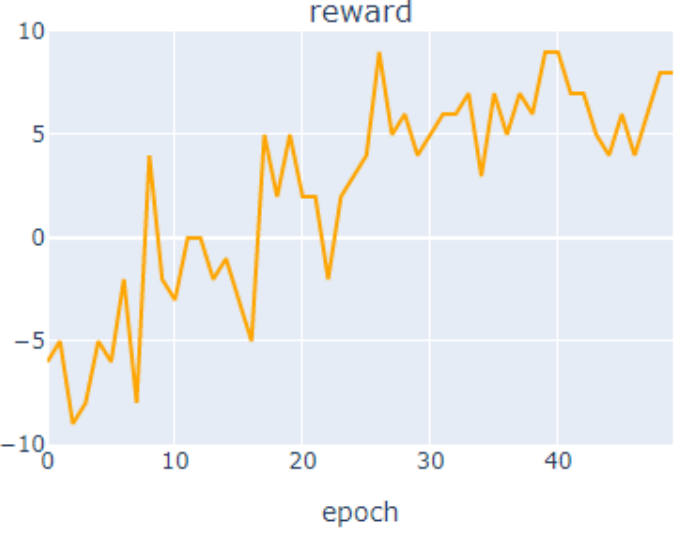
Figure 6. Quad Q Network-based intelligent autoscaler compensation value result. Table 4. Improved DQN-based auto-scaling performance test results.